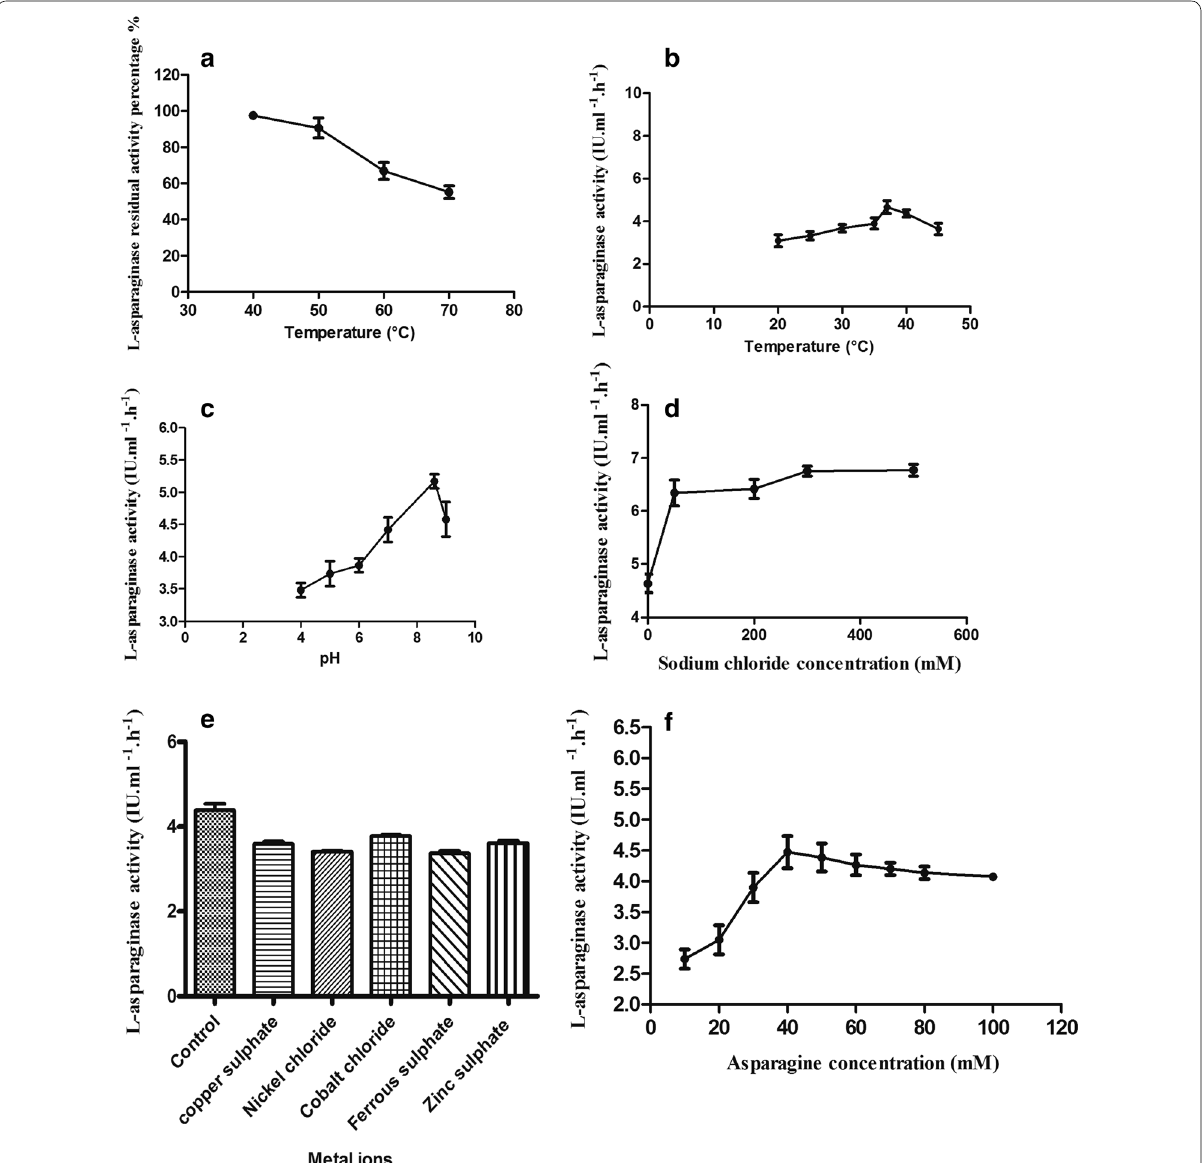
Fig. 3 Stability to temperature treatment ( a ), activities at various temperatures ( b ), pHs ( c ) and sodium chloride concentrations ( d ), substrate concentrations ( e ) and metal ions ( f ) of l -asparaginase produced by Stenotrophomonas maltophilia EMCC2297. In all cases ( a – d ) p-values were < 0.0001 which indicates high significance of the